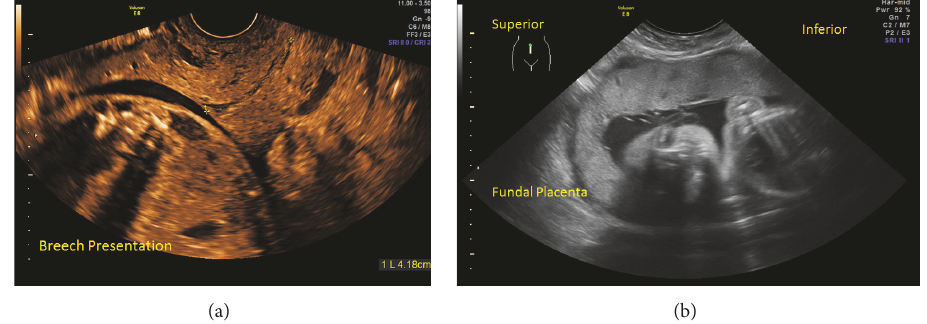
Figure 3: (a) Endovaginal ultrasound at 26 weeks showing a normal cervical length of 4.16 cm. (b) Transabdominal ultrasound showed a fundal placenta with breech